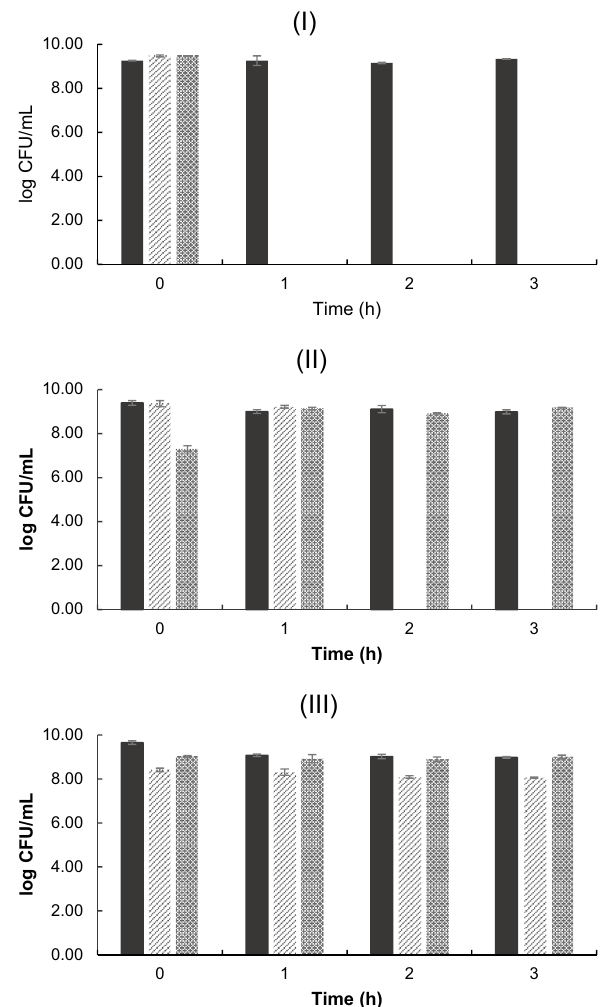
Figure 1. Tolerance of L1 ( I ), L2 ( II ) and EF ( III ), to pH 3 ( ) and 0.3% bile salts ( ). Strains without treatment of acid and bile salts were used as controls (filled black square). Bars represent means ± standard deviation, n =